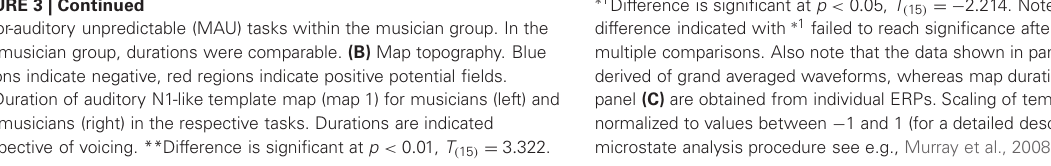
∗ 1 Difference is significant at p < 0 . 05, T ( 15 ) = − 2 . 214. Note that the difference indicated with ∗ 1 failed to reach significance after correction for multiple comparisons. Also note that the data shown in panels ( A and B ) are derived of grand averaged waveforms, whereas map durations shown in panel (C) are obtained from individual ERPs. Scaling of template maps is normalized to values between − 1 and 1 (for a detailed description of the microstate analysis procedure see e.g., Murray et al.,